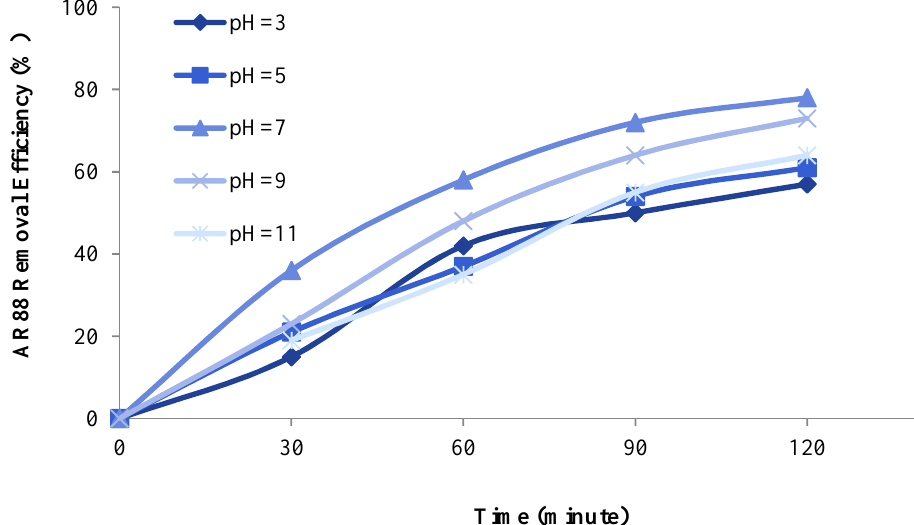
Figure 4. Effect of pH on the photocatalytic removal of Acid Red 88 (AR88) from aqueous solutions (initial dye concentration: 50 mg/l, time: 120 minutes)